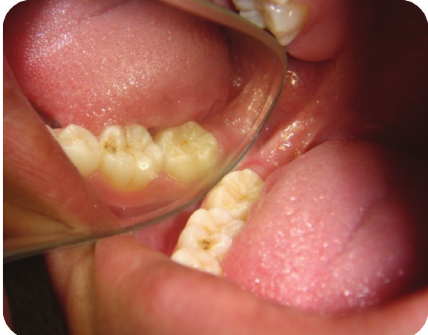
Figure 6: Posttreatment photograph with permanent mandibular second molar erupted.